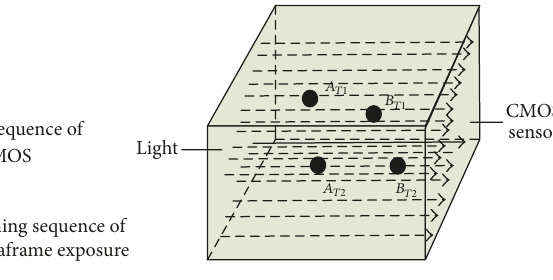
Figure 2: Principle of measurement.